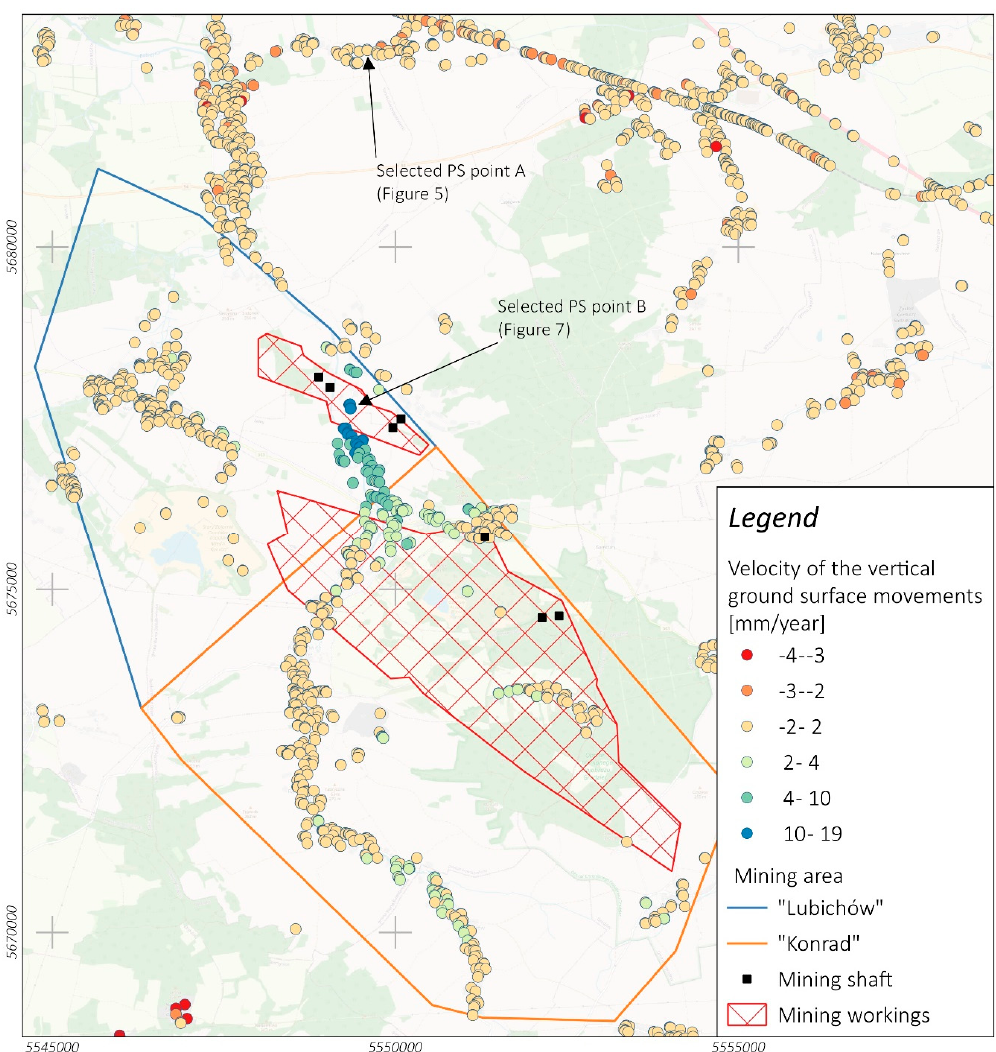
Figure 6. Estimated vertical movements of the ground surface due to groundwater recharge in the period